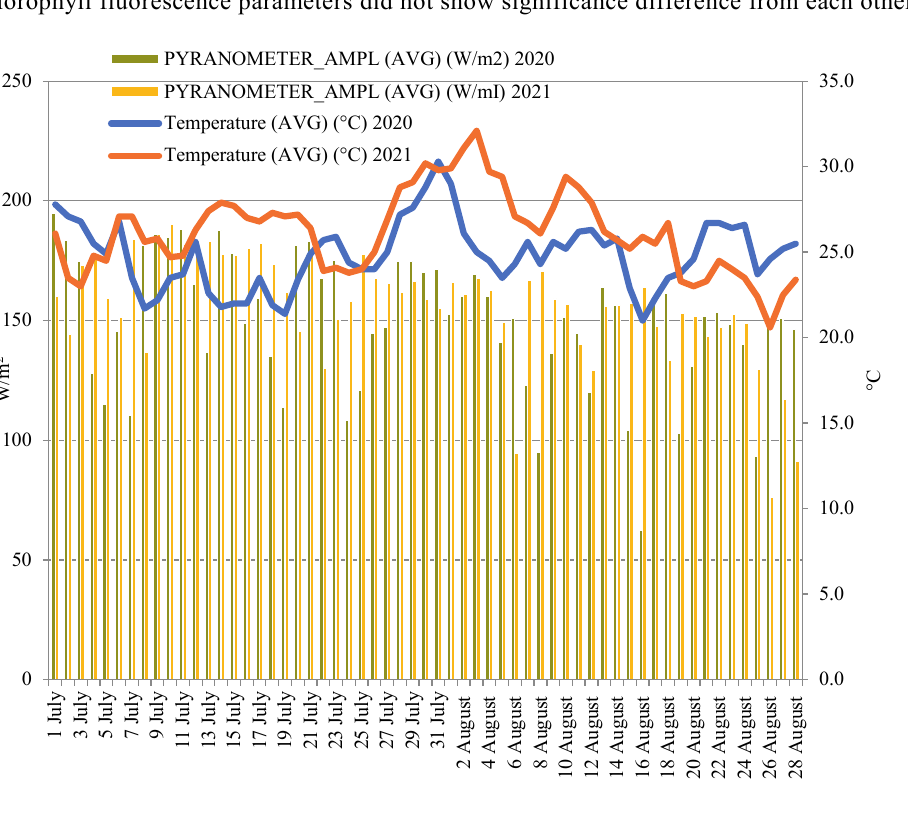
Fig. 1. Daily solar radiation (W/m 2 ) and the average daily temperature (degrees Celsius) in July and August for the measurement period in 2020 and